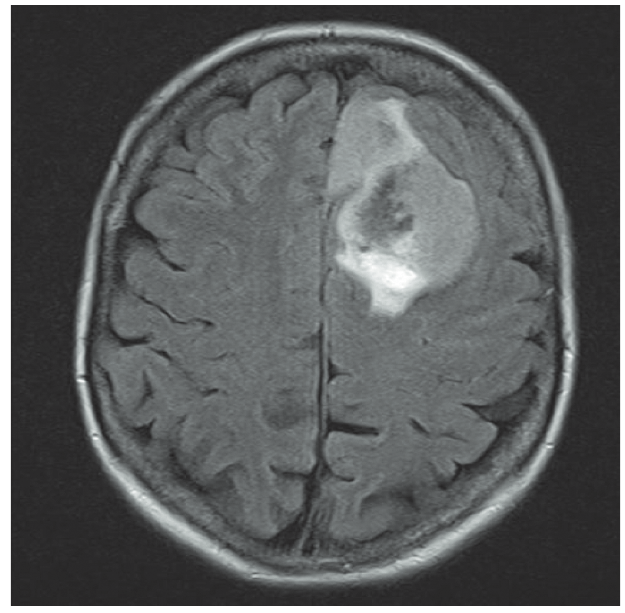
Fig. 4b. Follow-up FLAIR axial view shows a large lesion with mass effect and surrounding